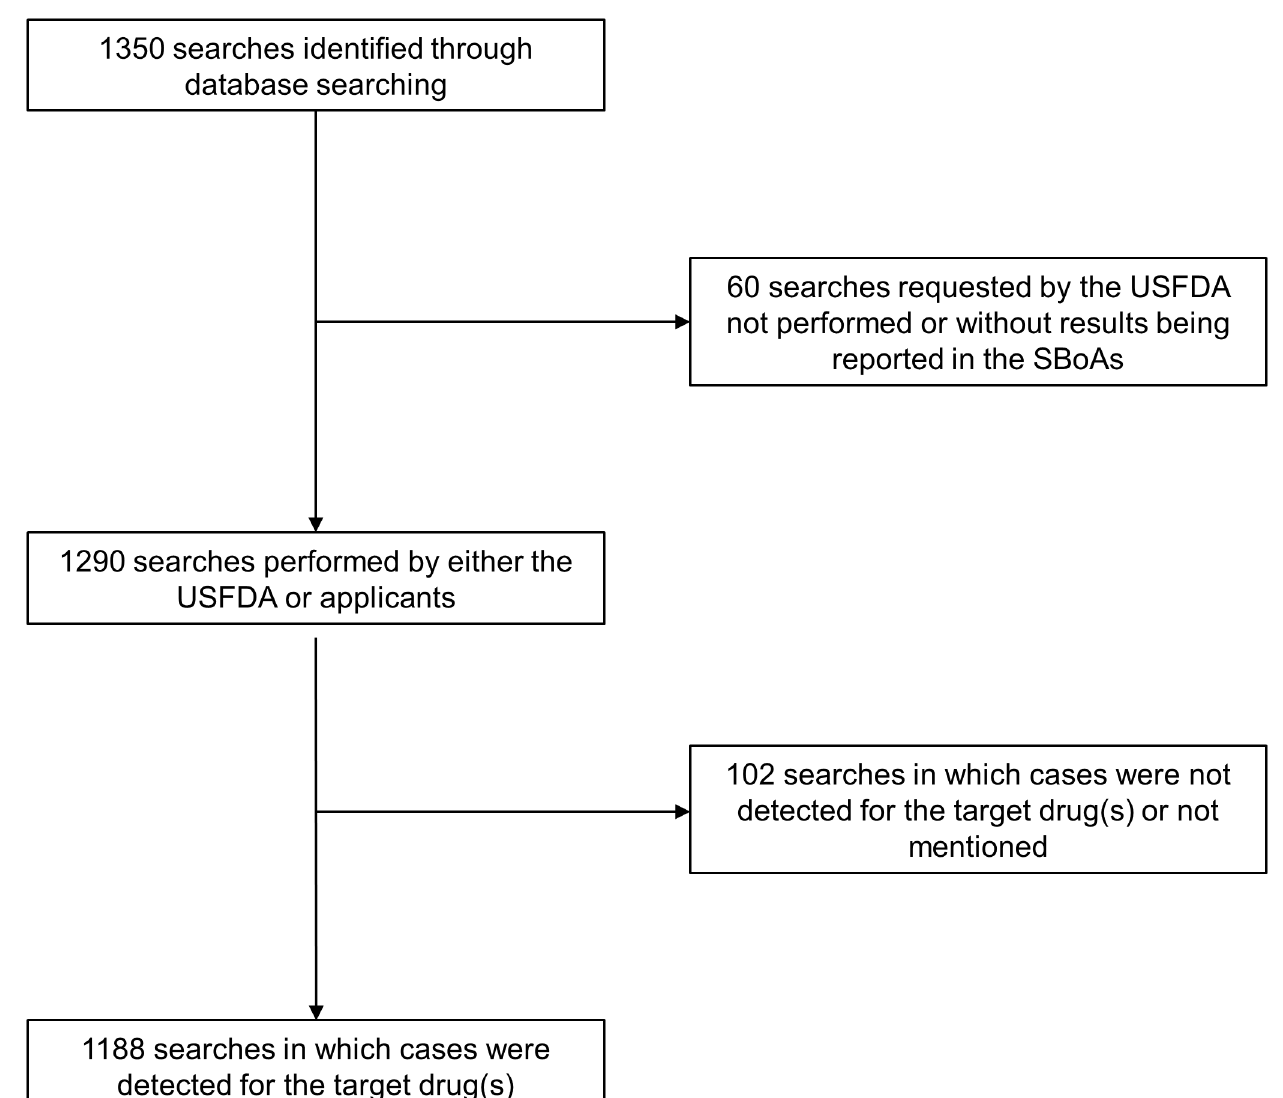
Fig 1. The diagram of the numbers of Standardised MedDRA Query (SMQ) searchesinvestigated. SBoAs, Summary Basis of Approvals; USFDA, United States Food and Drug Administration.